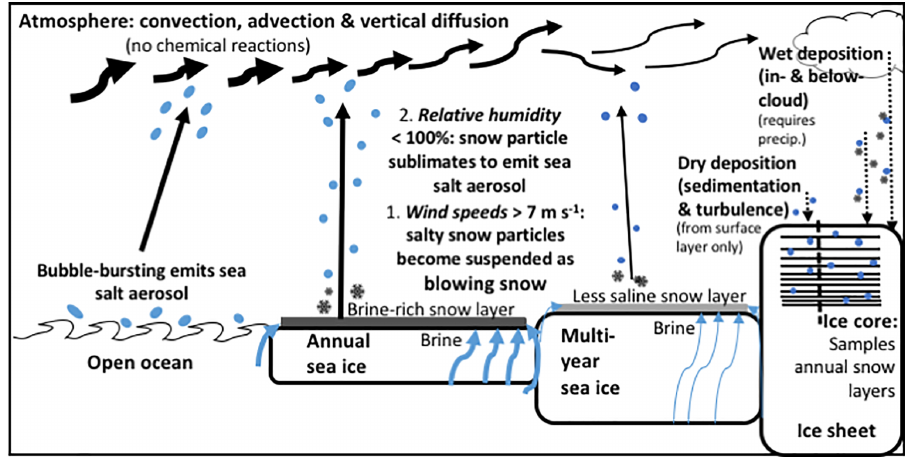
Figure 2. Schematic of processes parameterized by p-TOMCAT that influence sea salt concentrations in the atmosphere and ice cores.